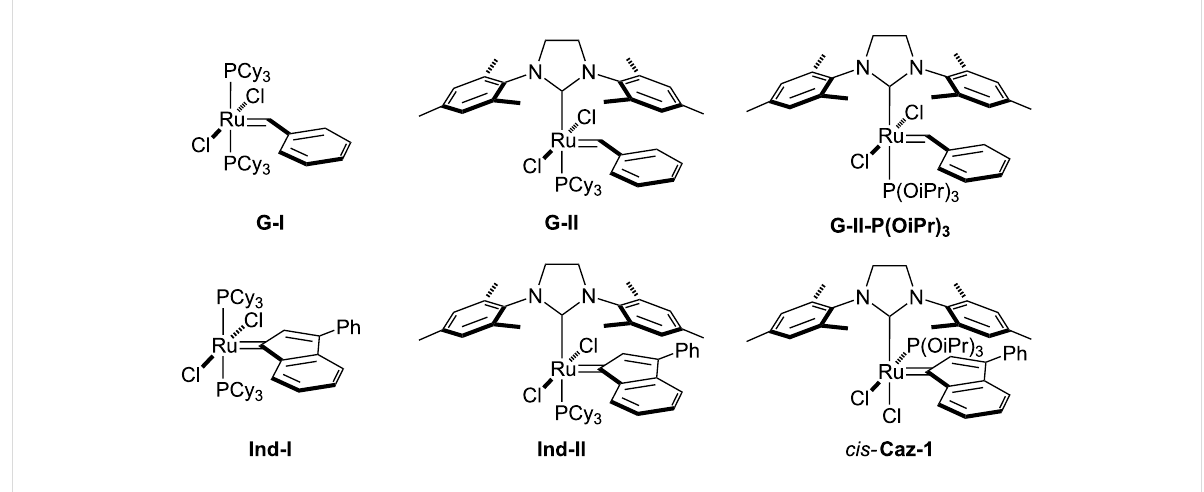
Figure 1: Examples of ruthenium complexes used in olefin metathesis reactions.